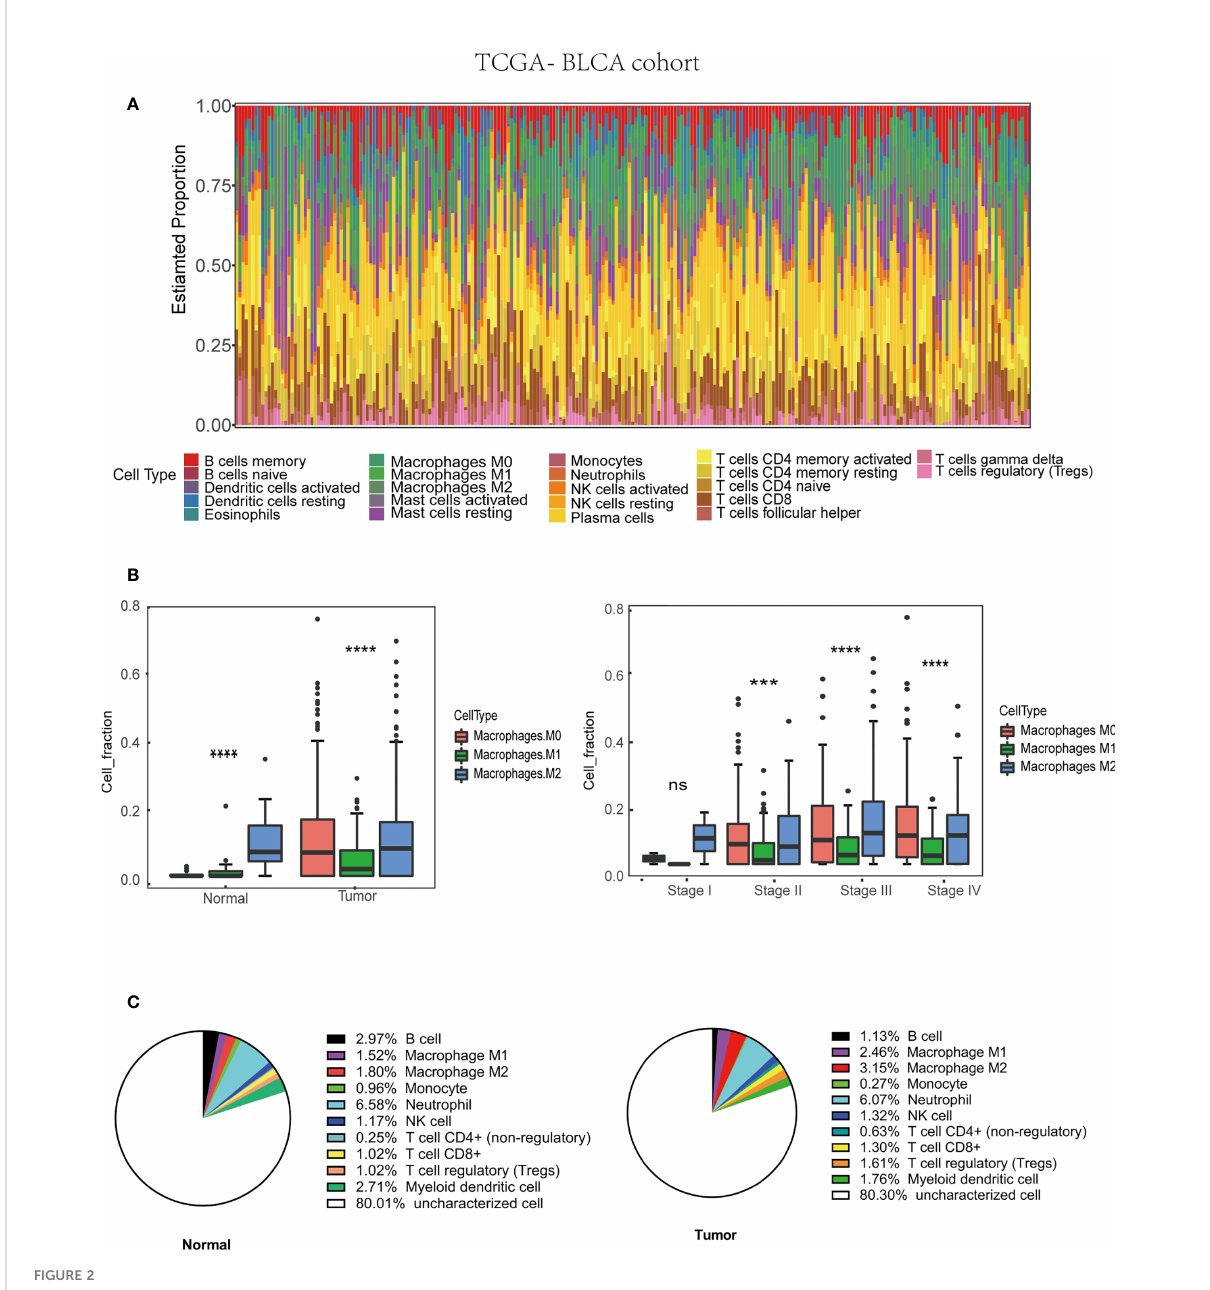
FIGURE 2 Tumor associated macrophages (TAMs) in fi ltration in TME based on TCGA-BLCA (Bladder Urothelial Carcinoma) cohort (430 patients). (A) Immune cells in fi ltration in bladder cancer patients. (B) M2 macrophages in fi ltration in various tissue and stage. (C) The average M2 macrophage fraction in differ tissue type based on QuanTIseq algorithm.***p < 0.001, ****p <